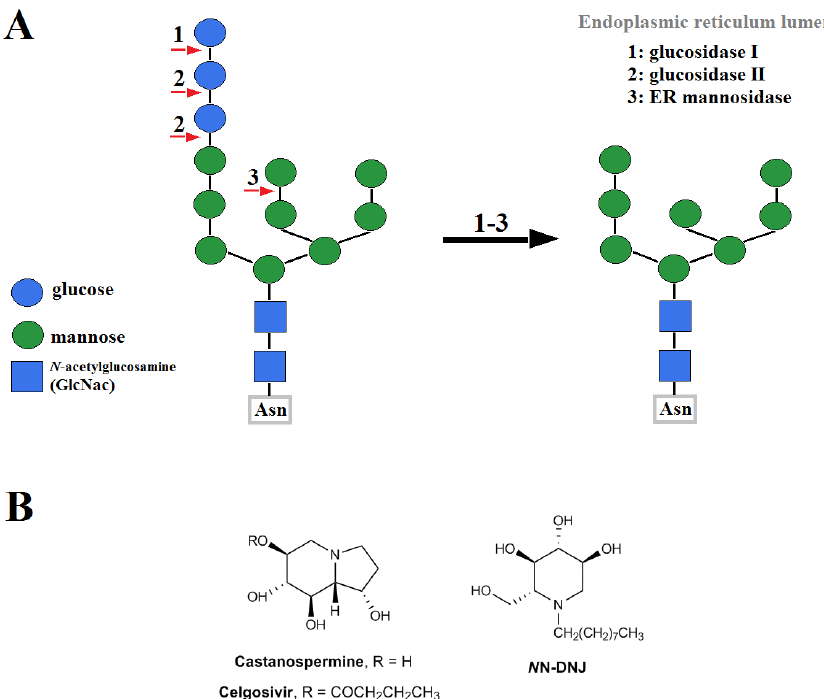
Figure 4. ( A ). Schematic of glucose- and mannose-removal by glucosidase I, II, and endoplasmic reticulum (ER) mannosidase during asparagine (Asn)-linked glycosylation in the ER lumen; ( B ). Chemical structures of α-glucosidase inhibitors, castanospermine, celgosivir, and N -nonyldeoxynojirimycin ( N N-DNJ).